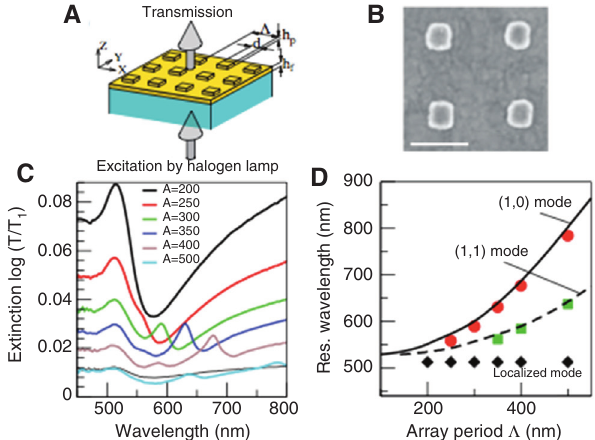
Figure 10: (A) Sketch of the sample and geometry of the experi- ment of Hohenau and Krenn [31]. The samples are illuminated from the glass-substrate side, the transmitted light is collected by a 2.5 × , 0.075 numerical aperture objective and analyzed by a spectro- meter; (B) exemplary SEM image; (C) extinction spectra of particle arrays with varying array periods. The reference for calculating the extinction is taken on the gold film outside the arrays. The thin line depicts the extinction spectrum of a sample with random particle distribution; (D) resonance wavelengths of the extinction peaks vs. array period: experimental values from (C) (symbols) and calculated values (lines) of different grating orders. Reprinted from Plasmonic modes of gold nano-particle arrays on thin gold films, Phys. status solidi – Rapid Res. Lett., 2010, 4, 256–258. Copyright Wiley-VCH Verlag GmbH & Co. KGaA. Reproduced with